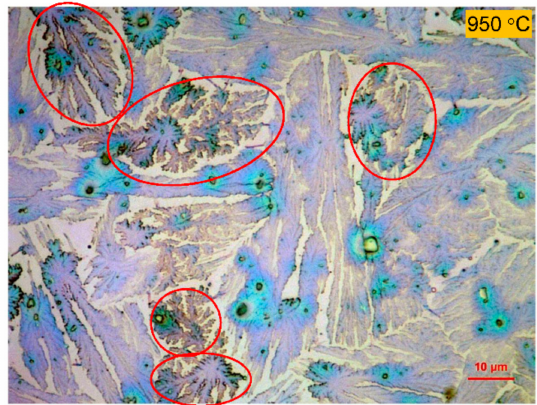
Figure 8. Optical micrograph of the CuIC micro-Si thin film with (glass / p-type Si / Cu) structure after annealing at 950 ◦